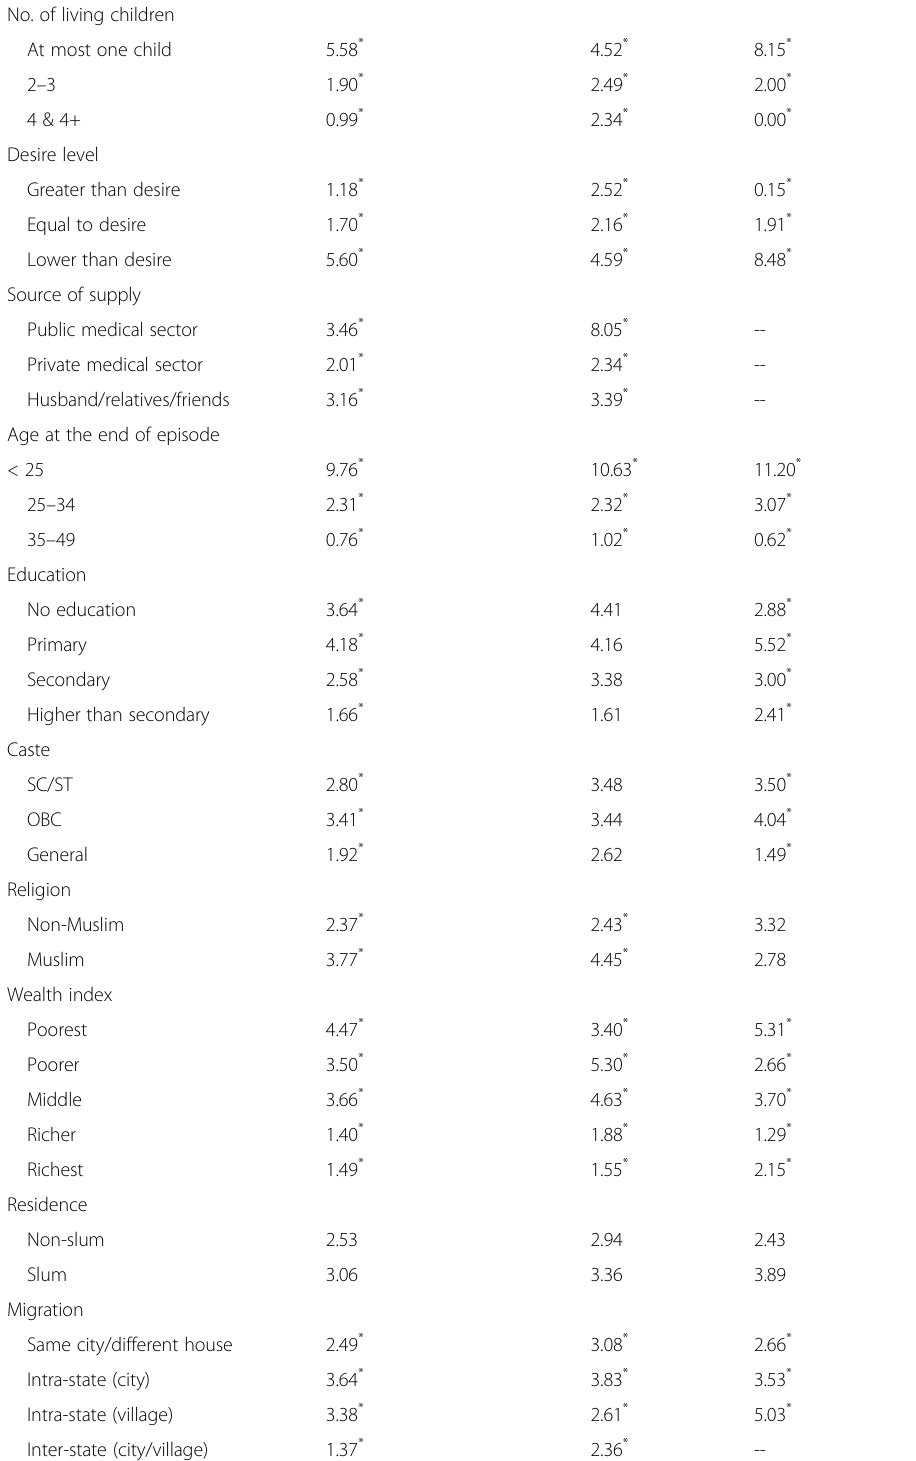
Table 3 Life table failure rates for all reversible method, traditional method, and condom by selected background characteristics of users, Uttar